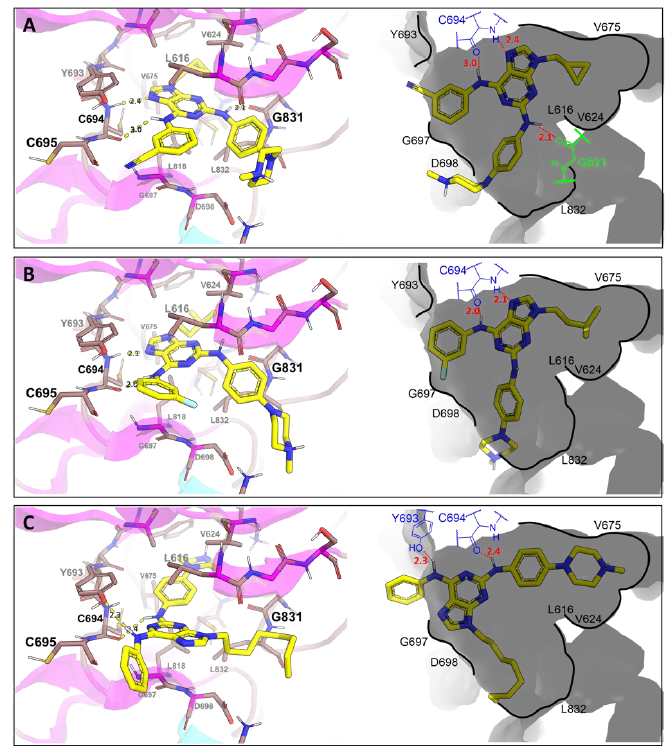
Figure 10. Representations of the binding modes of compounds 4f ( A ), 5b ( B ) and 5j ( C ) at the FLT3 active site. The image on the right is the three-dimensional representation of the best docking result for each compound. The image on the left is a top view of a diagram of the ligand interactions with the binding site. Considering the proposed chemical modifications on V (Figure 3), Figure 11 summa- rises the results obtained via SAR and in silico studies (3D-QSAR and molecular docking) in this work.